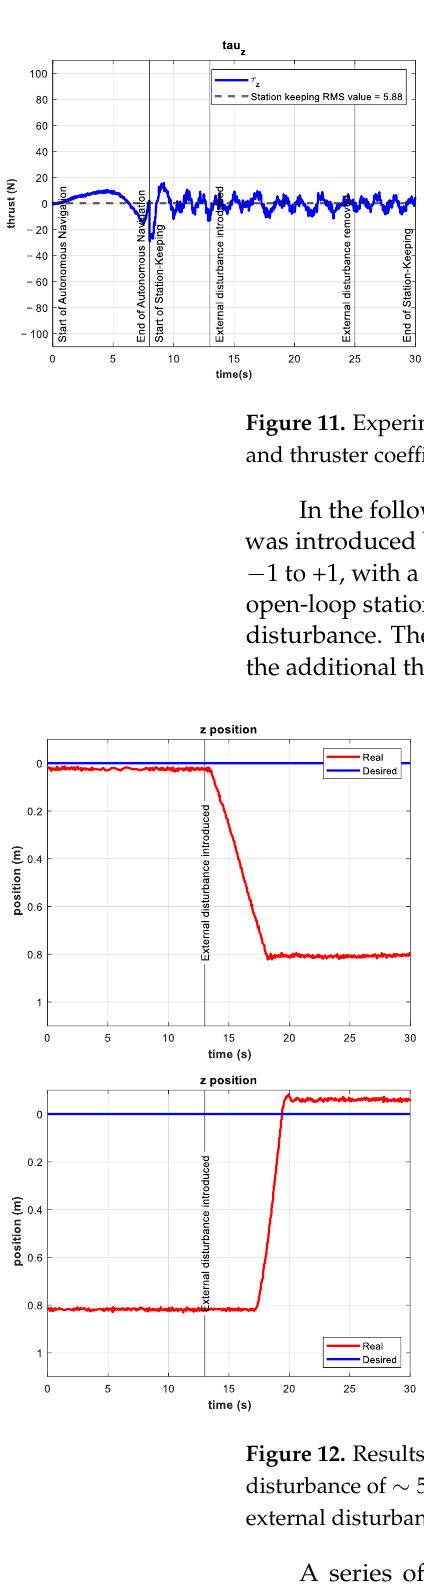
Figure 10. Depth ( left ) and tracking error ( right ) results of the control test. No external disturbances were introduced.